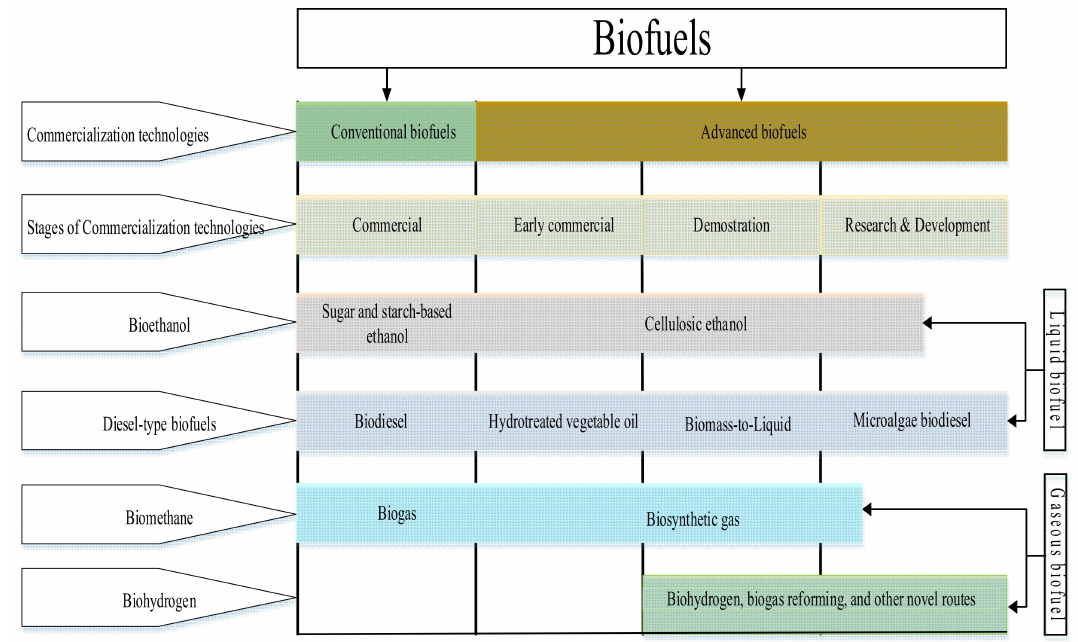
Figure 2. Classification of biofuels based on technology maturity. Adapted from [52]. Developed by the